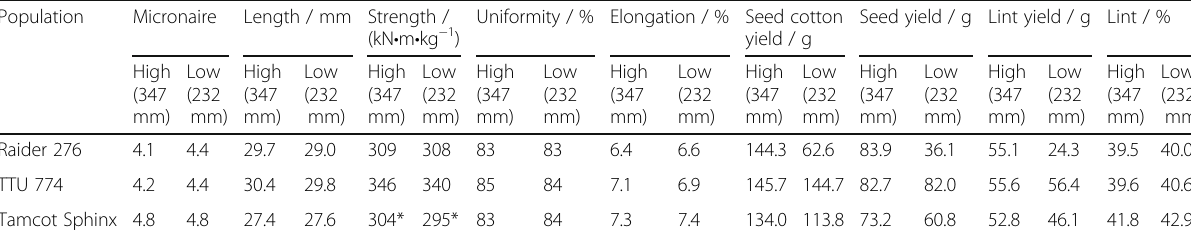
Table 1 Fiber quality of superior selections across two irrigation rates at Location 1 (Lubbock, TX) in 2014